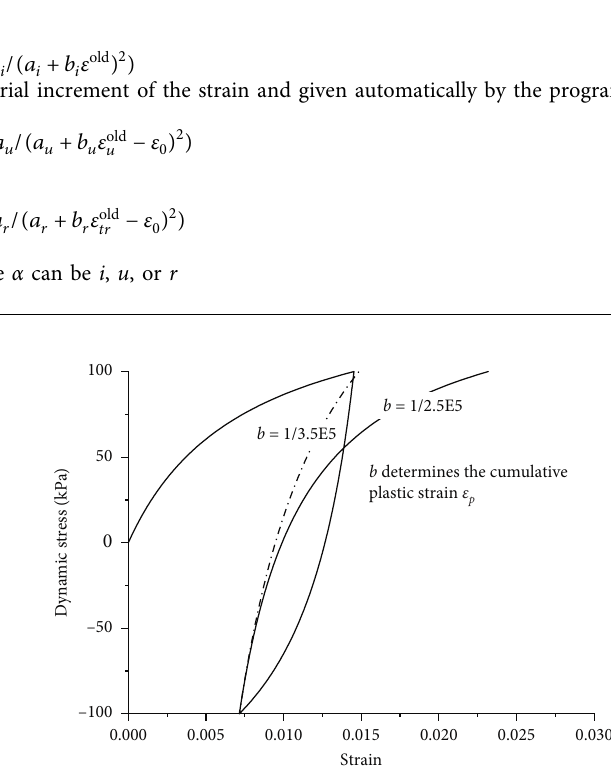
Figure 9: The effect of parameter a on the stress-strain curve. Figure 10: Effect of parameter b on the stress-strain